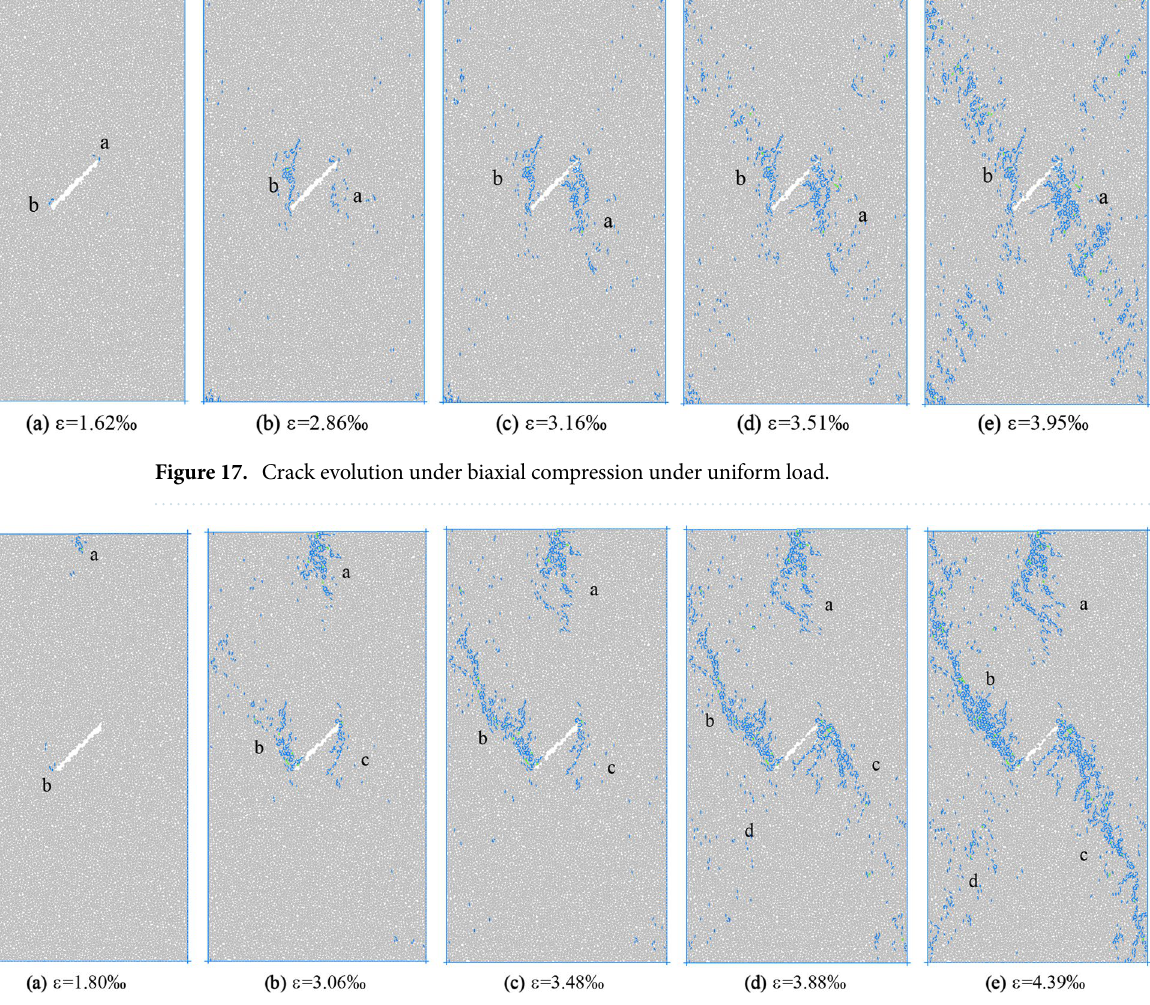
Figure 18. Crack evolution under biaxial compression under eccentric